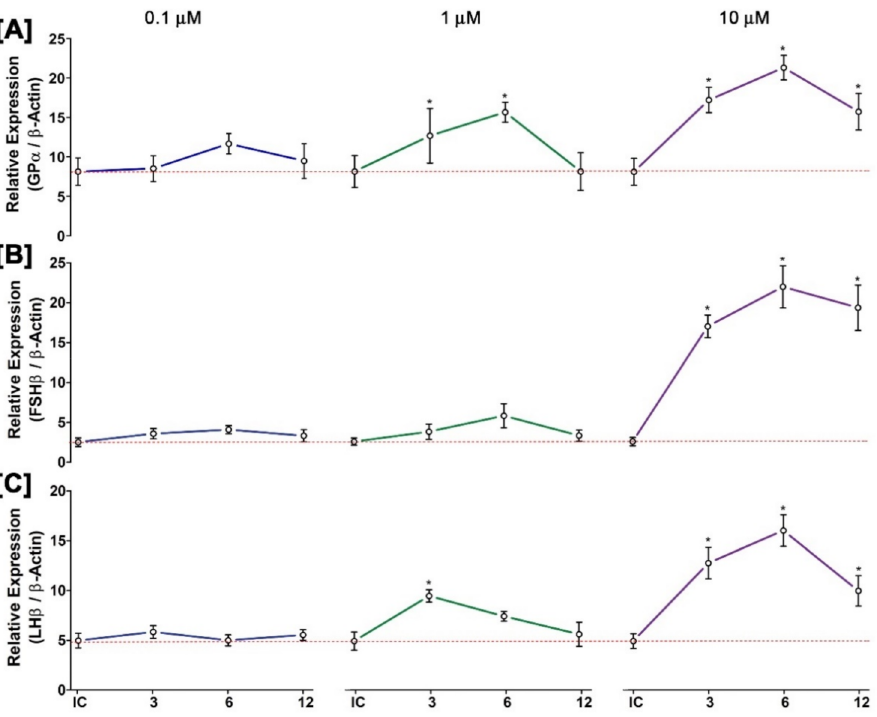
Figure 11. Time- and dose-dependent in vitro effects of GnRH1 peptide on mRNA expression levels of three GtH subunits in cultured pituitary of small yellow croaker: ( A ) GP α , ( B ) FSH β , and ( C ) LH β . GnRH1 peptide was applied in the culture media at concentrations of 0.1, 1, and 10 µ M. Asterisks indicate significant differences ( p < 0.05) compared zero time point initial control (dotted lines).